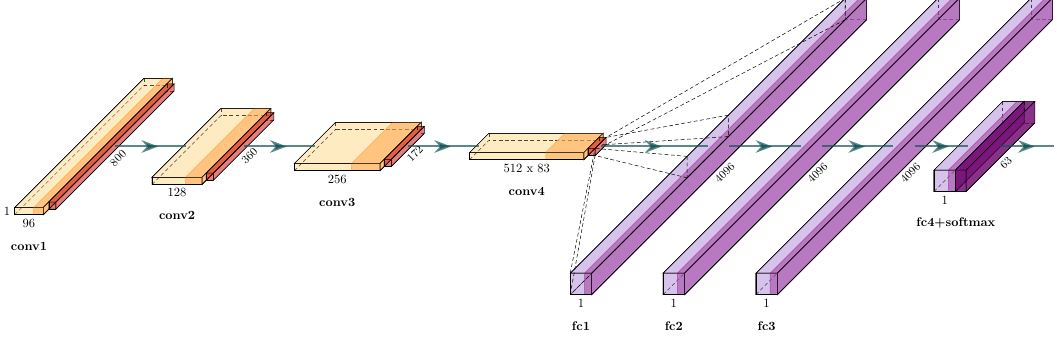
Figure 7. CNN proposed in [10] aiming at ECG recognition for the verification task.